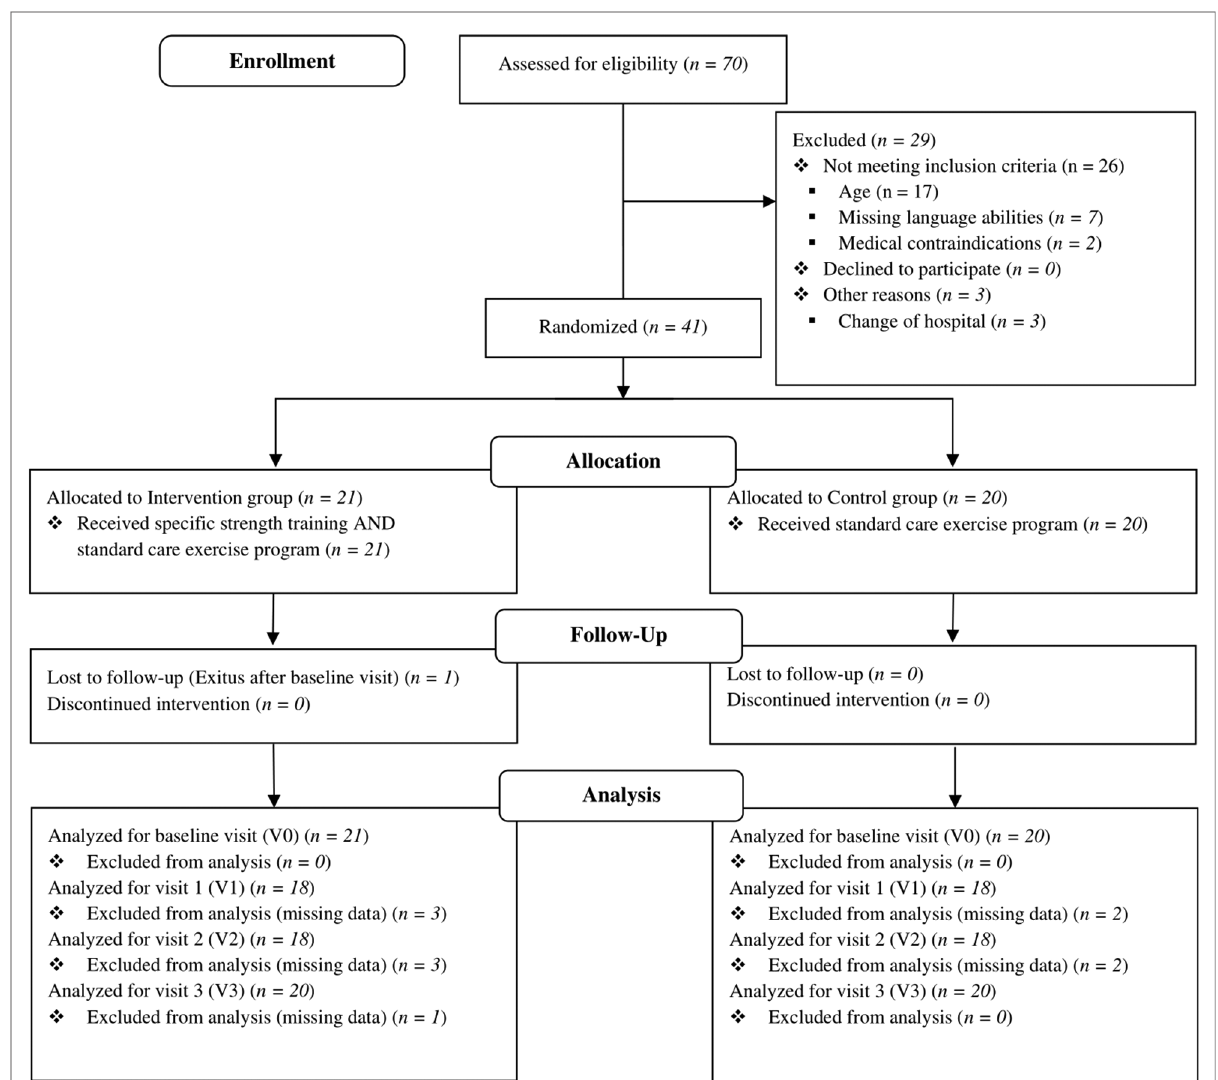
FIGURE 1 Participant fl ow following CONSORT 2010 (35). Medical contraindications were pneumonia/sepsis with long-term ventilation and intussusception with biliary